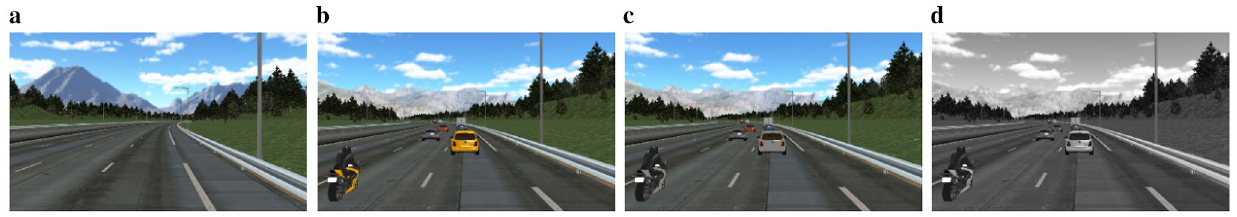
Fig. 2 An example of the images generated with Pro-SiVIC: a normal image, b anomalous original image, c anomalous modified image, d anomalous greyscaled